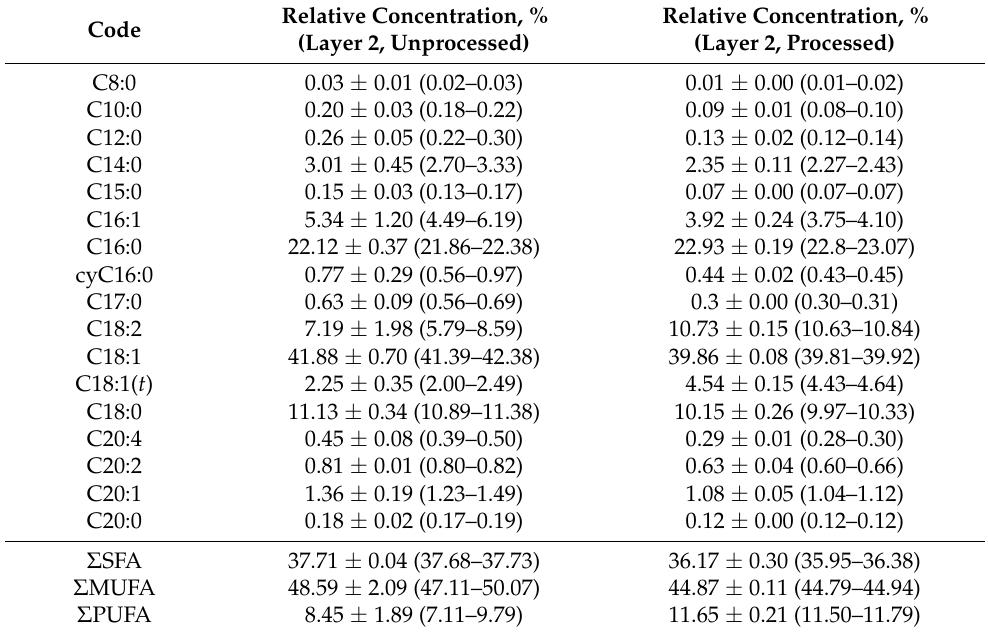
Table 3. Relative concentrations of the main FAMEs identified by GC-MS analysis in the raw (unprocessed) and thermally processed lipid fraction (layer 2, codes U2 and P2) from Mangalitza hard fat. Values are expressed as mean ± SD and data range (in